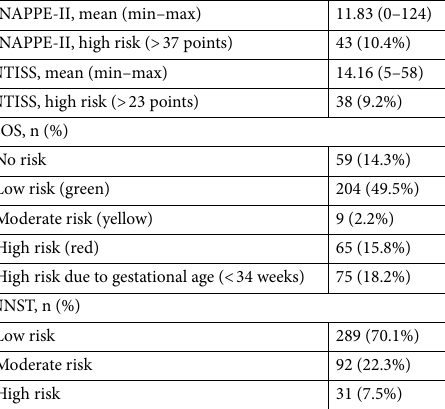
Table 2. Risk scores of the study population (N = 412). SNAPPE-II Score for neonatal acute physiology with perinatal extension-II, NTISS Neonatal therapeutic intervention scoring system, EOS Early-onset sepsis risk calculator, NNST Neonatal nutrition screening tool.